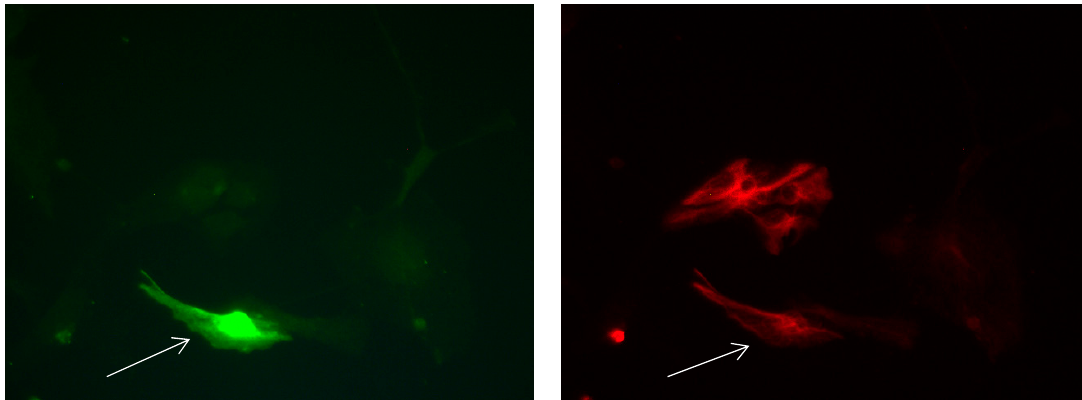
Figure 14. Cultures in a serum-free medium, 1 day (2 days after the passage): Immunofluorescence with anti-GFAP (glial fibrillary acidic protein) (red, secondary antibody: donkey anti-goat IgG Alexa Fluor 594), and with anti-Calbindin D28k (polyclonal antibody from the company SWANT) (green, secondary antibody: donkey anti-rabbit IgG Alexa Fluor 488). Epifluorescence microscopy. One Calbindin D28k positive and GFAP-positive astrocyte (long arrows).